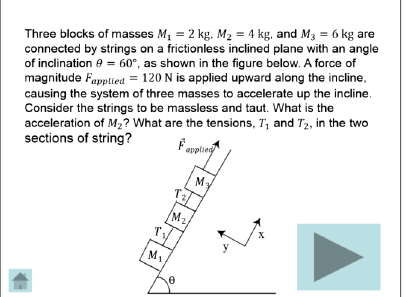
FIG. 1. The overarching problem in the Newton ’ s second law